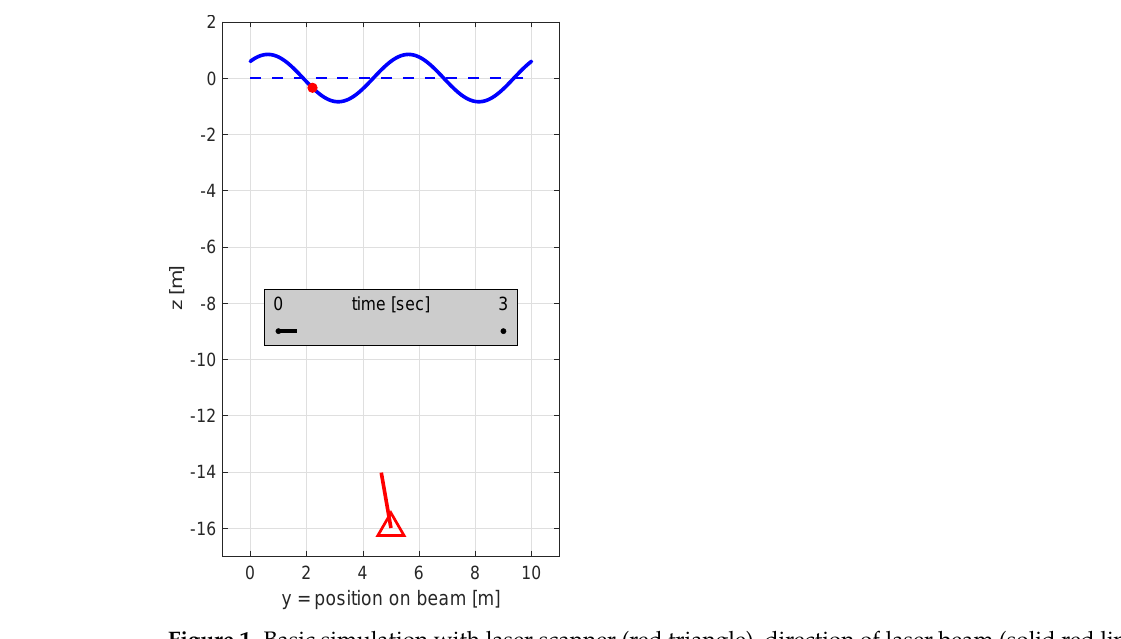
Figure 1. Basic simulation with laser scanner (red triangle), direction of laser beam (solid red line), scan point on structure (red dot), static mean value of observed structure (dashed blue line) and oscillating structure (solid blue line, 20-times oversubscribed for better